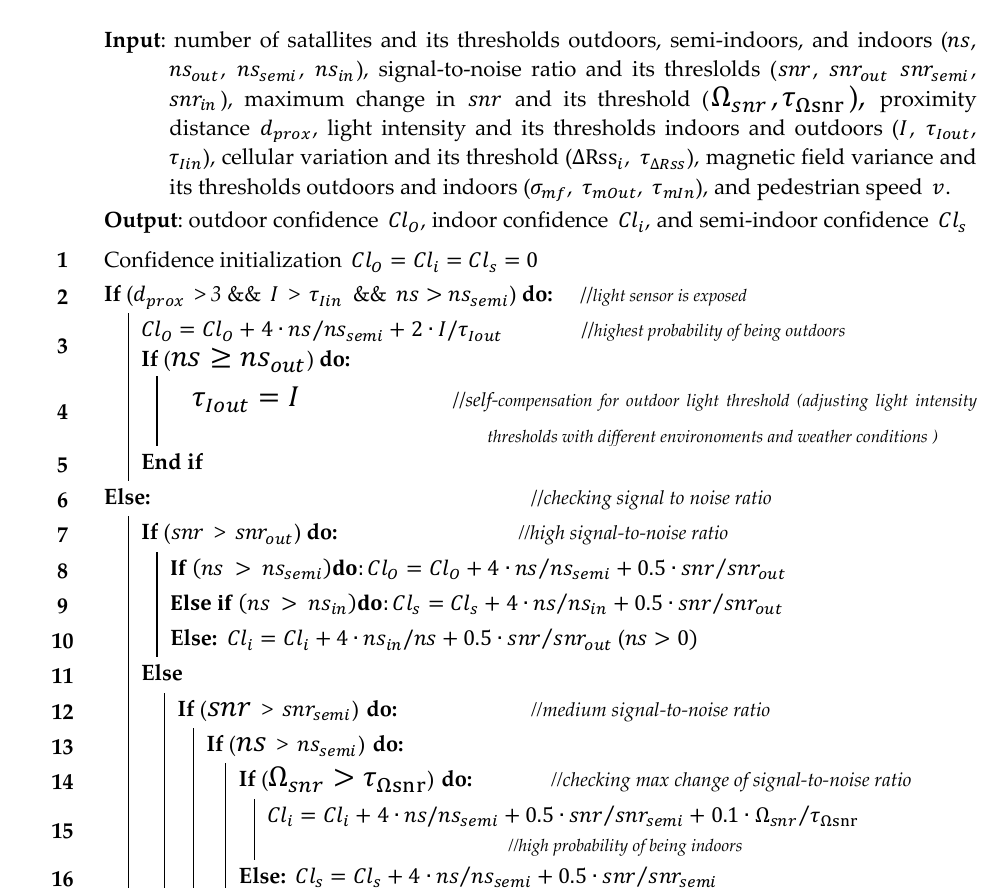
Algorithm 1: Aggregated I/O decision-based LPCS and GNSS indicators